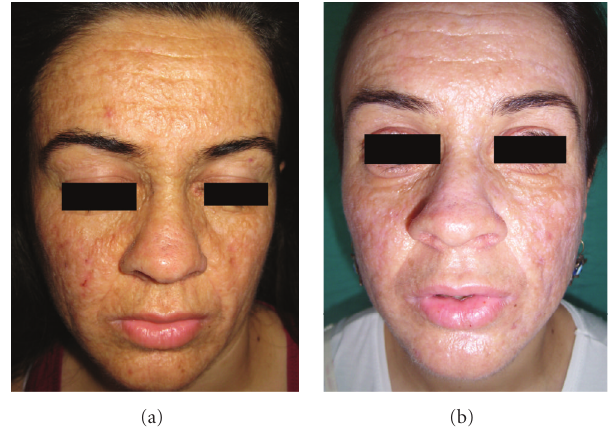
Figure 4: Comparison between the start (a) and end of acitretin therapy (b). After 6 months, improvement of cutaneous lesions was not satisfactory, but there was significant improvement of